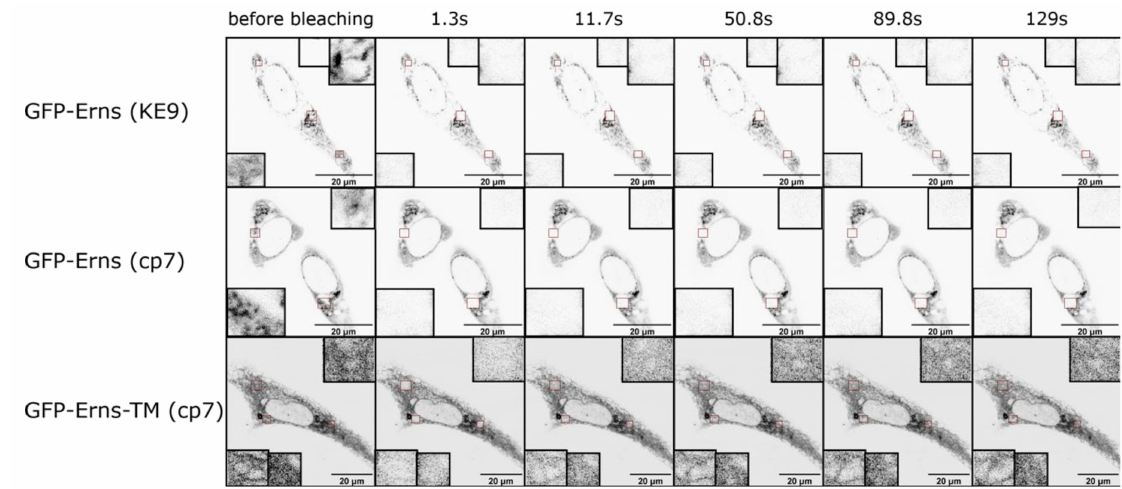
Figure 5. E rns is statically retained in the ER. BHK-21 cells were transfected with plasmids coding for different GFP tagged variants of E rns , namely E rns of BVDV CP7 (GFP-E rns CP7), E rns of BVDV KE9 (GFP-E rns KE9) and E rns of BVDV CP7, in which the membrane anchor had been replaced by a hydrophobic sequence (GFP-E rns -TM CP7). The transfected cells were used in FRAP experiments. Shown are images directly before the bleaching and at the indicated time intervals after bleaching. The bleached areas are magnified in the insets in the